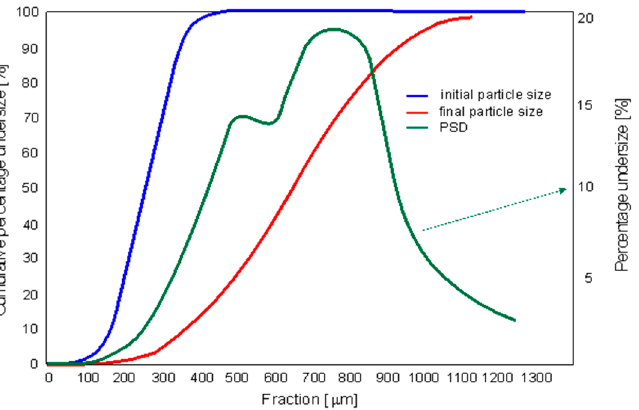
Figure 14. Cumulative initial and final and percentage undersized PSD in the industrial tower. Experimentally determined percentage undersized PSD shows a bi-modal distribution as in [25,36].